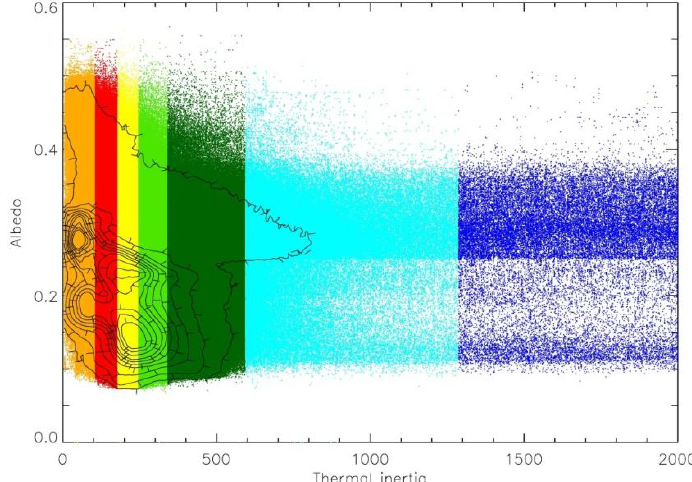
Figure 8. ISODATA classification into seven classes, where the albedo and thermal inertia datasets have not been normalized. The boundaries between classes do not correspond to the underlying distribution of pixel values shown by the